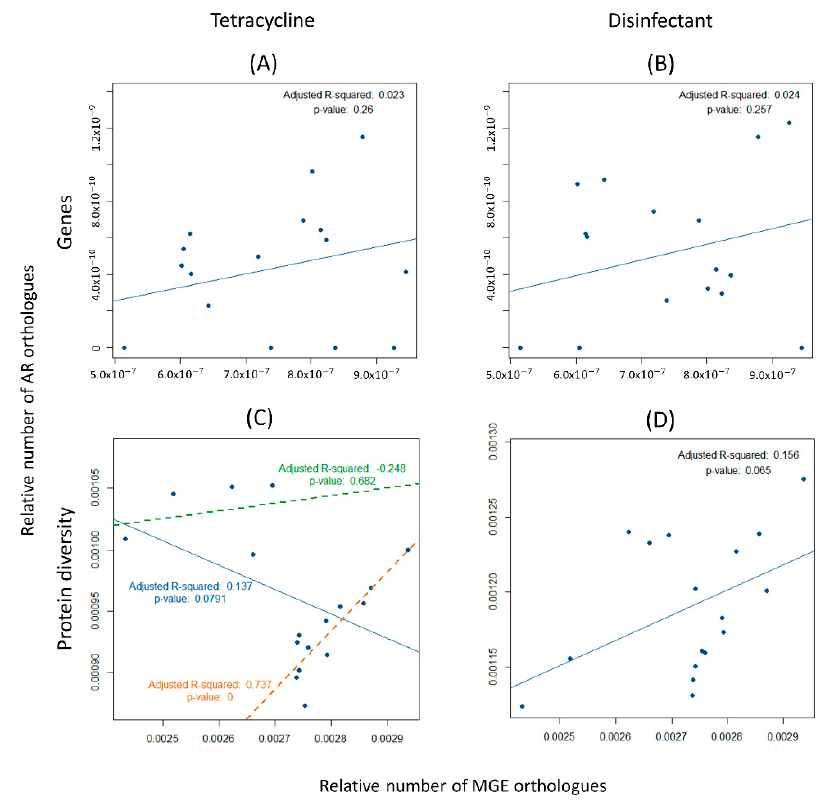
Figure 6. Correlation between antibiotic resistance (AR) orthologues for two ResFinder categories and mobile genetic elements (MGEs) for the Sado River. Each point represents a metagenome. ( A ) Positive correlation between the relative number of tetracycline encoding resistance genes and mobile genetic elements (Adjusted R-squared = 0.023, p -value = 0.26). ( B ) Positive correlation between the relative number of disinfectant encoding resistance genes and mobile genetic elements (Adjusted R-squared = 0.024, p -value = 0.257). ( C ) Negative correlation between the diversity of tetracycline resistance proteins and mobile genetic elements (Adjusted R-squared = 0.137, p -value = 0.079). The points agglomerate into two distinct clusters, leading to two positive correlations: one identified by the green regression line (Adjusted R-squared = − 0.248, p -value = 0.682), and the other identified by the orange regression line (Adjusted R-squared = 0.737, p -value = 0). ( D ) Positive correlation between the diversity of disinfectant resistance proteins and mobile genetic elements (Adjusted R-squared = 0.156, p -value = 0.065).